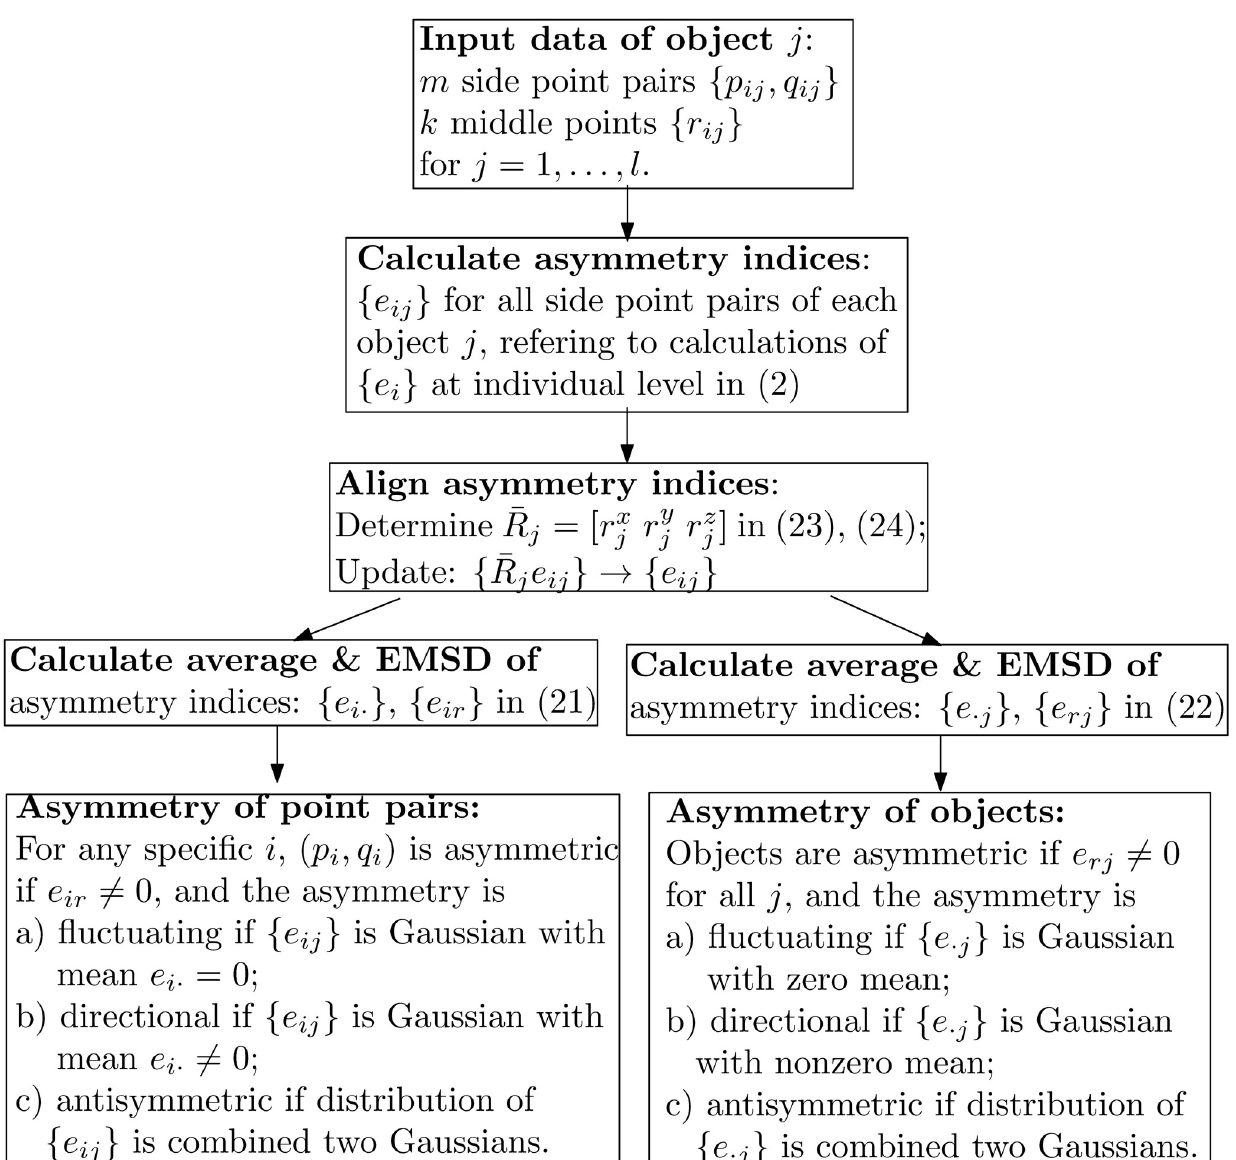
Fig 3. Flowchart of asymmetry assessments at collective